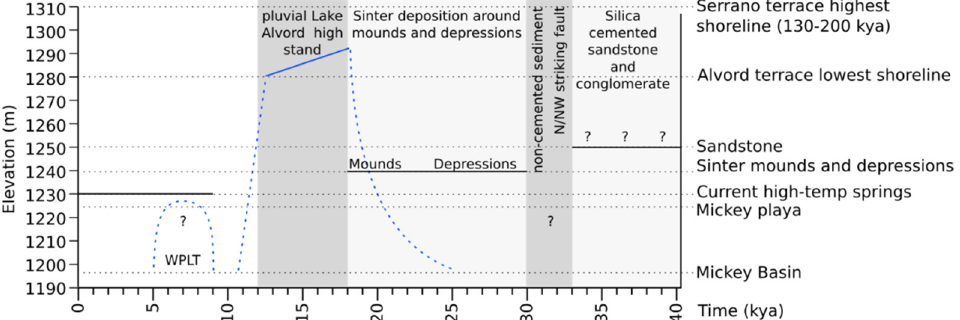
Figure 21. Timeline of major events at Mickey Springs. The scale on the left is the current elevation, and the elevation of relevant features are labeled on the right and indicated by the dashed grey line. The bottom time scale indicates thousands of years before present. The timeline of the hydrothermal activity at Mickey Springs is described in five steps, proceeding from right to left. (1) Silica cementation of sand and conglomerate prior to 30 kya (solid black line). (2) Offsetting of sandstone/conglomerate unit along the N/NW-striking fault, and deposition of uncemented sediments. (3) Deposition of laminar and pool-edge sinter around hot springs from 30 to 18 kya (solid black line). (4) Infilling of springs with lake sediment from pluvial Lake Alvord between 18 and 12 kya. (5) Current high-temperature springs (solid black line) active at lower elevation (1230 m), no sinter deposition, drying of climate to current desert conditions. Hypothesized (blue dashed line) and dated (solid blue line) level of pluvial Lake Alvord, including drying at 12 kya and slight resurgence during presence of Western Pluvial Lakes Tradition (WPLT).